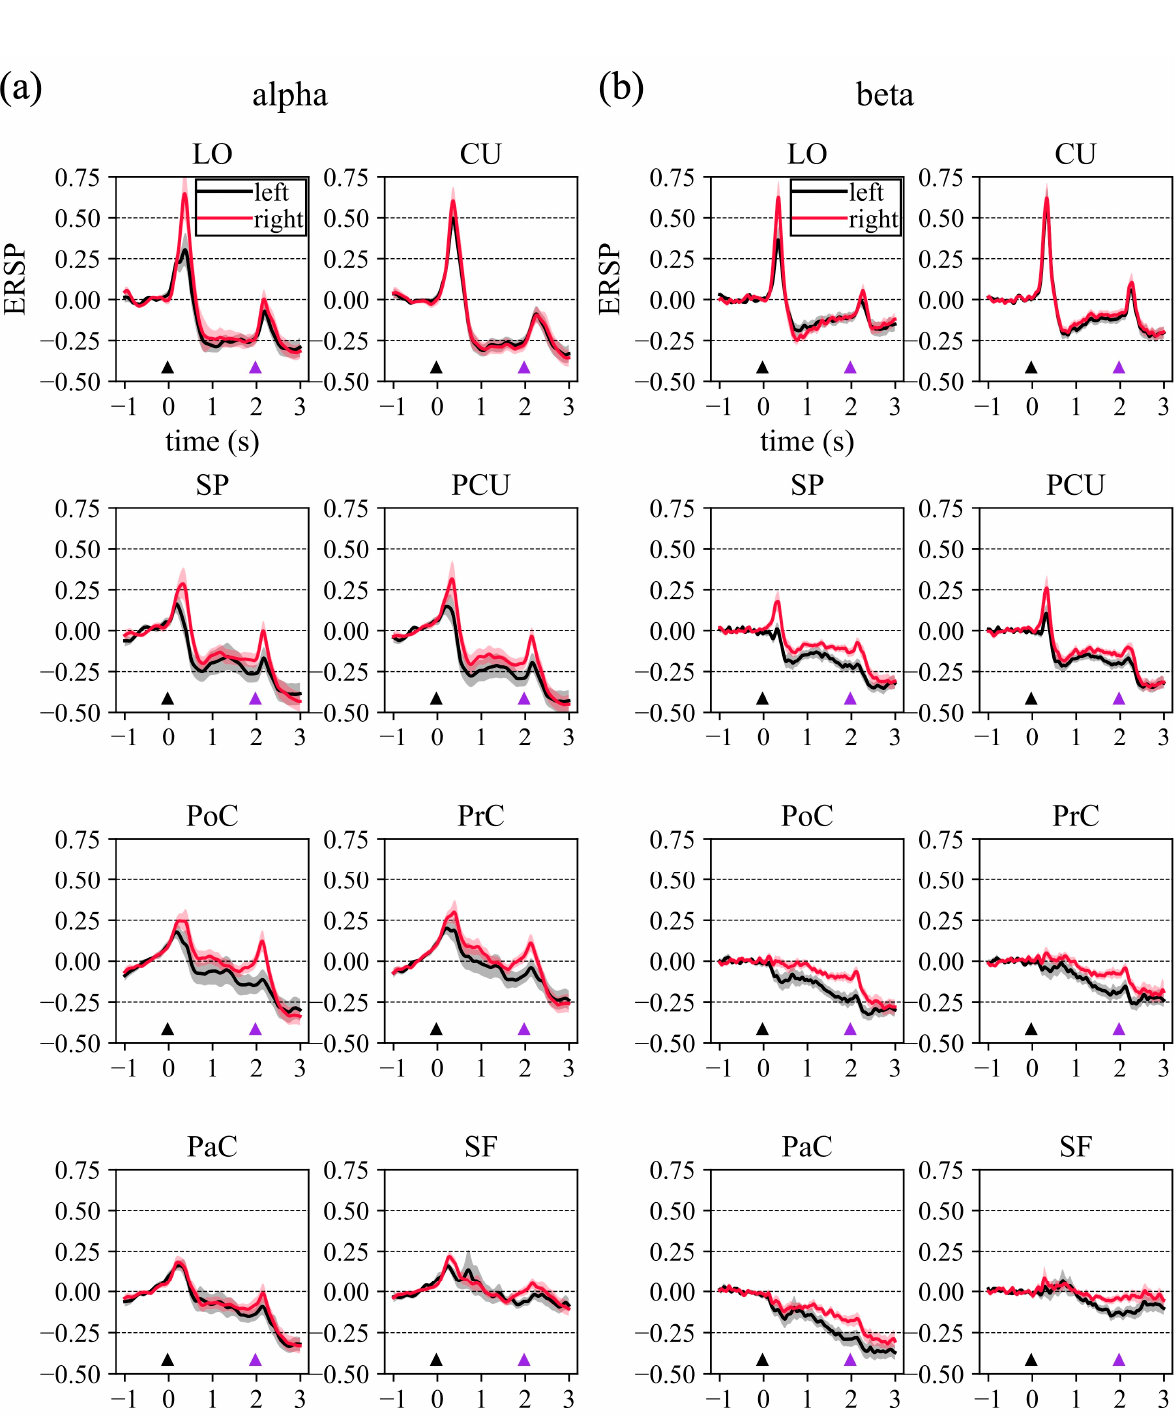
Figure 3. Alpha ( a ) and beta ( b ) event-related spectral perturbations (ERSPs). Here, the ERSPs reported in Figure 2 were averaged within alpha and beta bands and visualized as a function of time. The grand-average alpha-ERSP and beta-ERSP is reported for each selected ROI of the left (black thick lines) and right (red thick lines) hemisphere. Shaded areas denote the standard error of the mean across subjects (in grey for the left ROI, in red for the right ROI). The small black and purple triangles shown at the bottom of each plot mark the time associated with the cue onset and go onset of the center-out reaching movement, respectively. Note that in this figure, to increase the readability, x- and y-labels are reported only for the first plot.